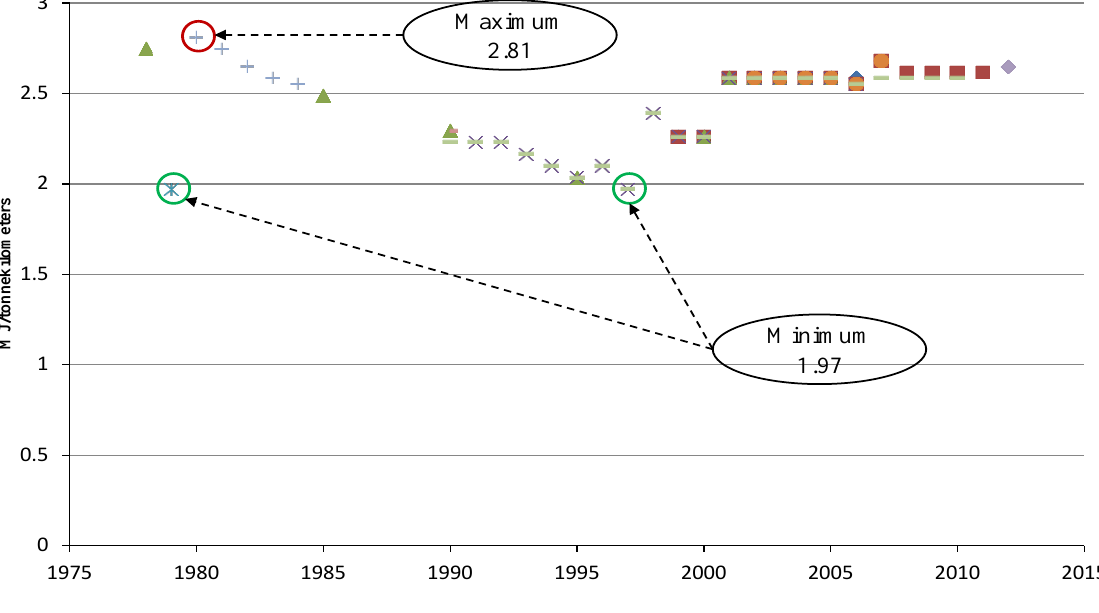
Figure 3. Energy consumption of truck powered by gasoline in China